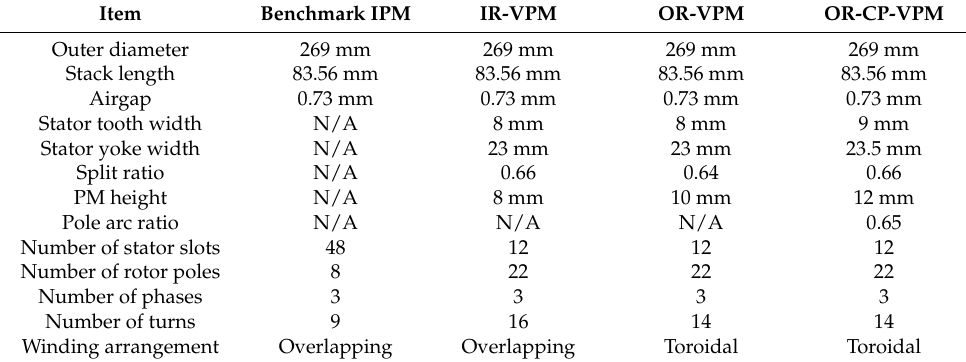
Figure 7. Variations of torque performances against different parameters: ( a ) Stator tooth width; ( b ) Stator yoke width; ( c ) Split ratio; ( d ) Permanent-Magnet (PM) height and ( e ) Pole arc ratio. Table 1. Key design parameters of the proposed motors.